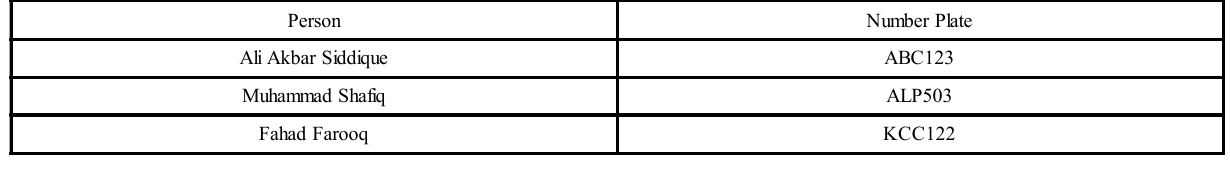
TABLE 2 SAMPLE DATABASE FOR NUMBER PLATE STORAGE ALONG WITH THE OWNER NAME